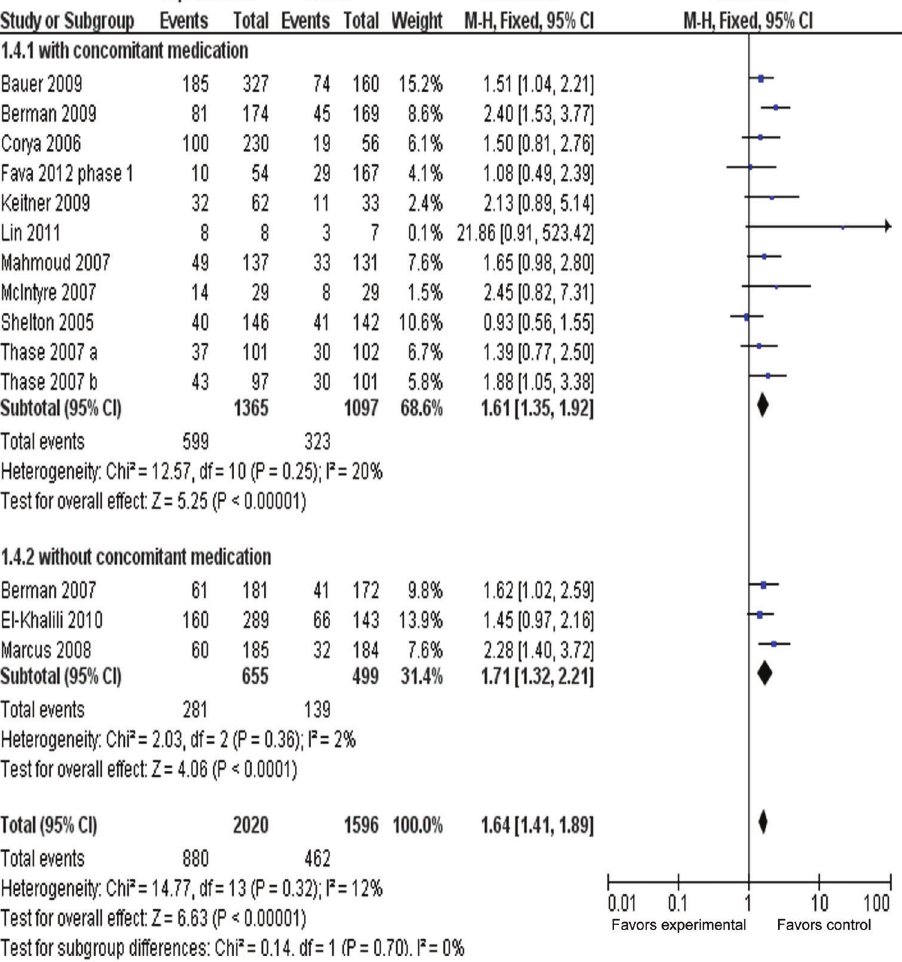
Figure 6. Meta-analysis of response rate in adjunctive treatment with or without sedatives. Odds ratios for response are grouped by with/without adjunctive treatment with sedative drugs, such as benzodiazepine, lorazepam, hypnotics. Fourteen trials were included in this subgroup